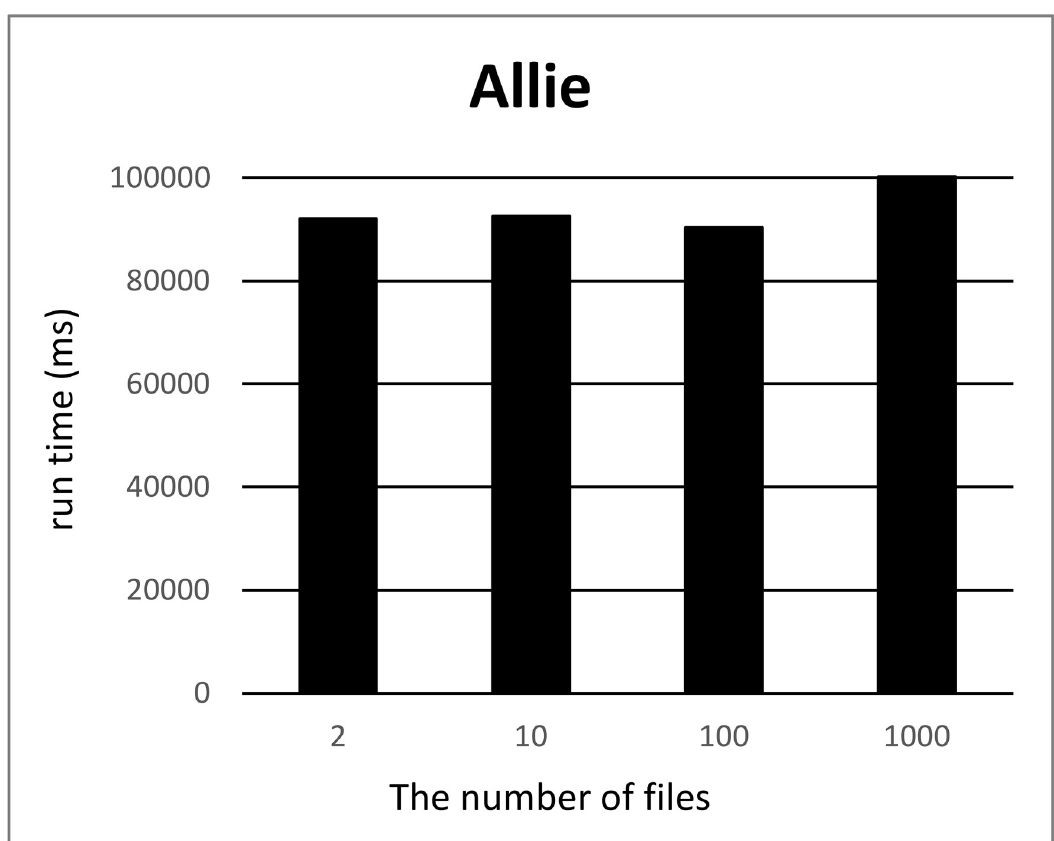
Fig 3. Computation time to split the Allie dataset. x -axis and y -axis correspond to the number of files (2, 10, 100, and 1000) and the average of running time [ms], respectively.